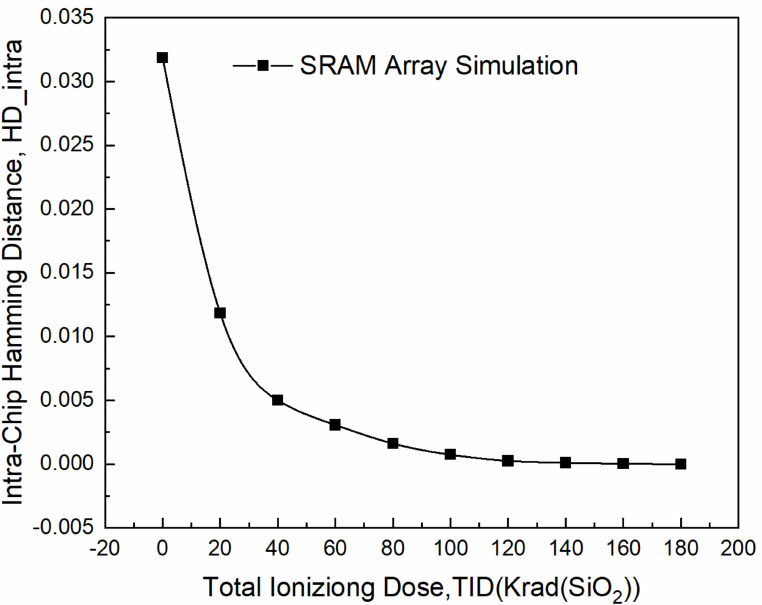
Figure 9. SRAM array simulation results, HD _ intra descends nonlinearly under TID e ff